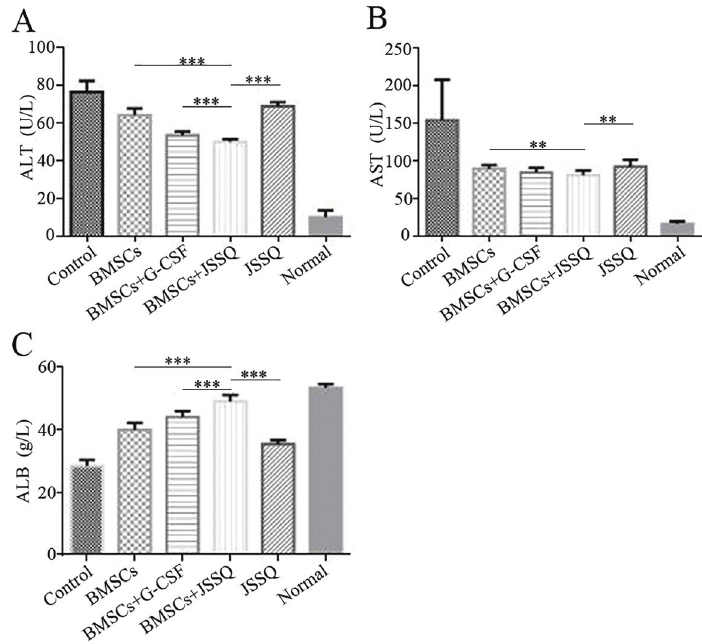
Figure 1. Expression of molecules on cells by fl uorescence immunoassay ( (cid:1) 400; A: 200 m m, B – D: 50 m m). Spindle-shaped inter-bone marrow stem cells ( A ), surface antigens included CD105 + ( B ), CD44 + ( C ), and CD34 + ( D ). Arrows indicate that isolated cells were bone marrow-derived mesenchymal stem cells.